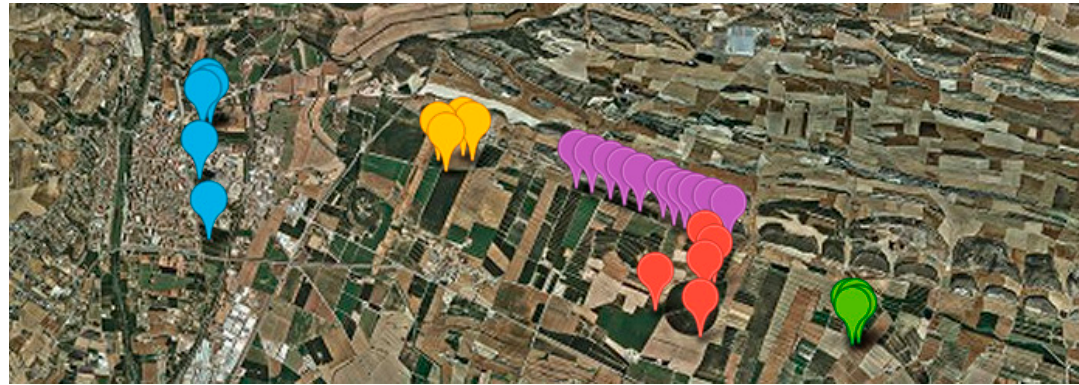
Figure 7. Locations where the soil samples, in situ soil moisture measurements, and surface roughness profiles acquired (refer to Figures 3 and 5).